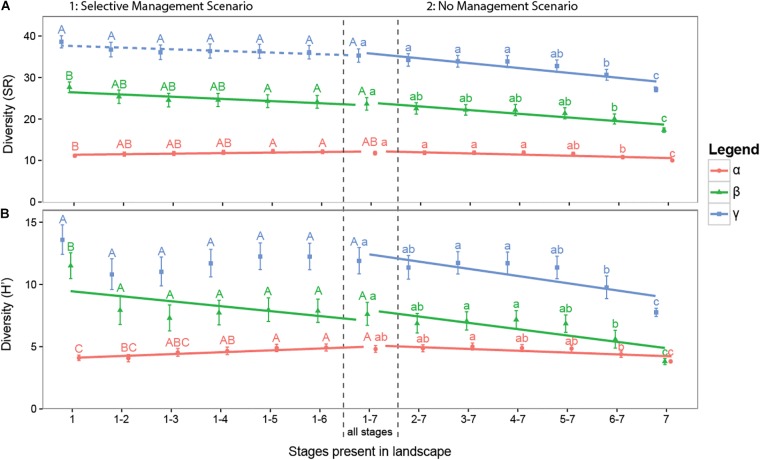
Simulation results of scenario analyses showing the effects of decreasing landscape-wide successional stage heterogeneity on the landscape diversity (γ) and its partitions (α, β) for both species richness (A) and true Shannon diversity H′ (B). On the left hand side the Selective Management scenario is shown, where late successional stages are progressively removed from the landscape. On the right hand side the No Management scenario is shown, where early successional stages are progressively removed from the landscape. Error bars show twice the standard error around the landscape-wide mean diversity values based on 21 simulated landscapes with 12 ditch reaches per landscape. Letters indicating pairwise significance between successional group means. Lines show significant trends (p < 0.05) along the gradient of management based on a linear model and dashed lines show marginally significant trends (p < 0.10).